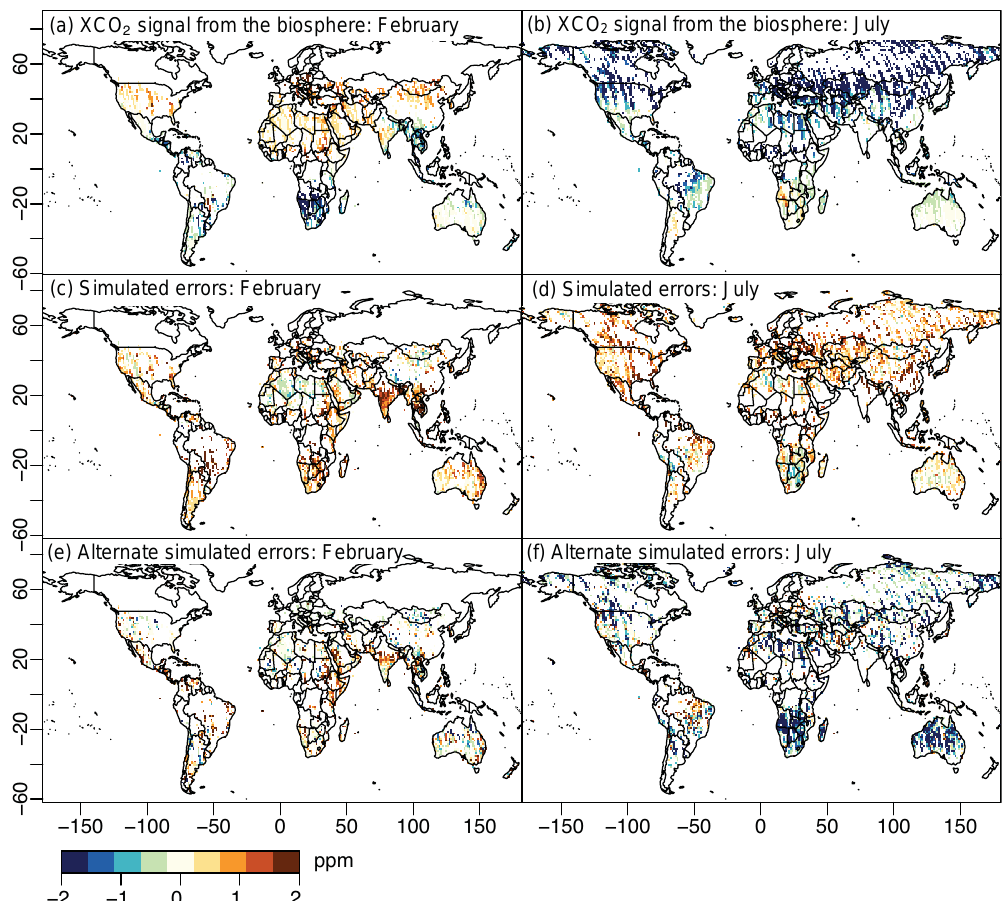
Figure 3. This figure compares the total column CO 2 or XCO 2 signal from biospheric fluxes against simulated model and observation errors. Panels (a) and (b) display the monthlong mean XCO 2 signal from biospheric CO 2 fluxes for February and July, respectively. We estimate this signal using the SiBCASA flux model and PCTM. Also note that the XCO 2 signal for February and July includes CO 2 fluxes from the months of February and July, respectively, and no fluxes from previous or subsequent months. Panels (c) and (d) represent the sum of both simulated observation and atmospheric transport errors (monthlong mean, Sect. 2.2). Panels (e) and (f) show the sum of these errors using an alternate estimate for the retrieval